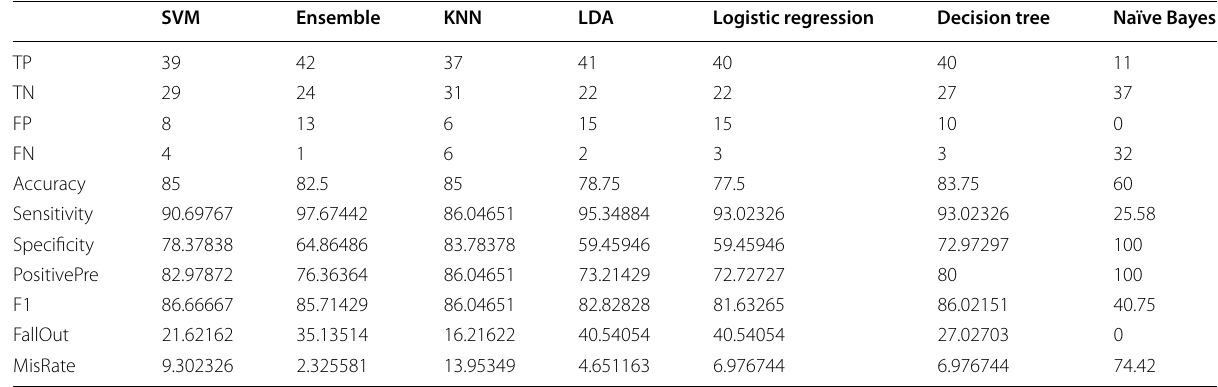
Table 6 Evaluation of the metric parameters for the seven classifiers of the random case testing method